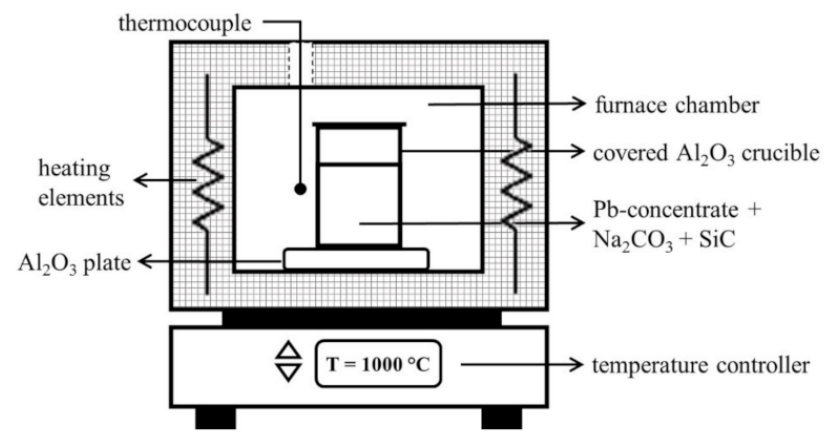
Figure 1. Experimental setup for lead recovery from a lead concentrate with Na 2 CO 3 and SiC to 1000 ◦ C. Each experiment lasted 1 h to 1000 ◦ C. Reaction time was started when the temperature measured by the thermocouple was equal to the temperature programmed in the electric resistance furnace. After the reaction time, the furnace was turned off. The products metal and slag were poured and cooled down in a pre-heated iron mold. Metallic lead and slag were separated, weighed, and analyzed by AA, XRD, and SEM-EDS techniques. In Figure 2 is the flow chart of the proposed